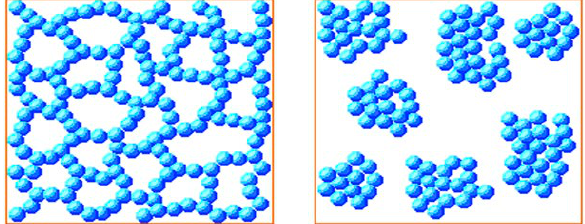
Figure 49. This diagram is a two-dimensional representation of the difference between a three-dimensional gel meshwork with its cross-linked chains of silica spheres and a precipitate of three- dimensional clusters of colloidal silica globules.